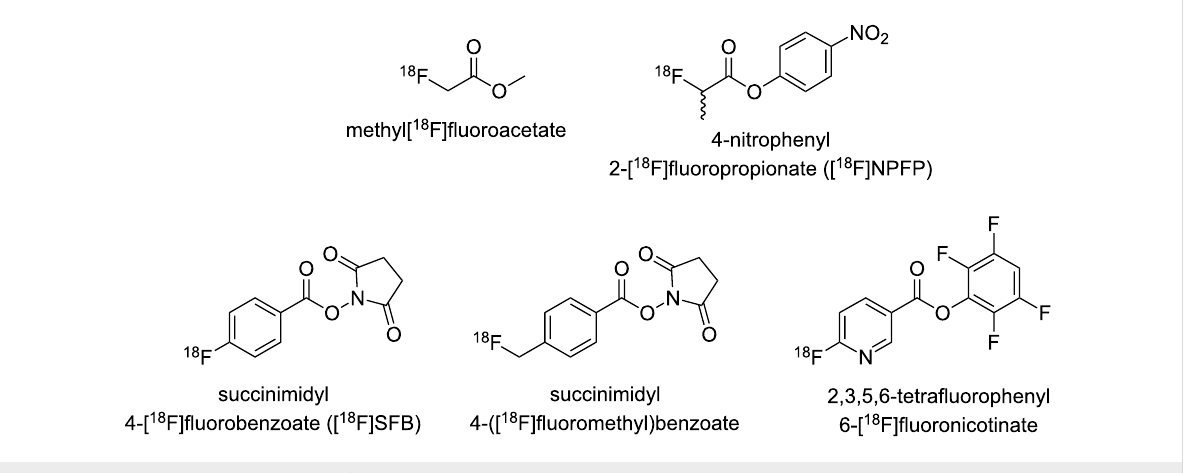
Figure 1: Selection of prosthetic agents for 18 F-labelling via